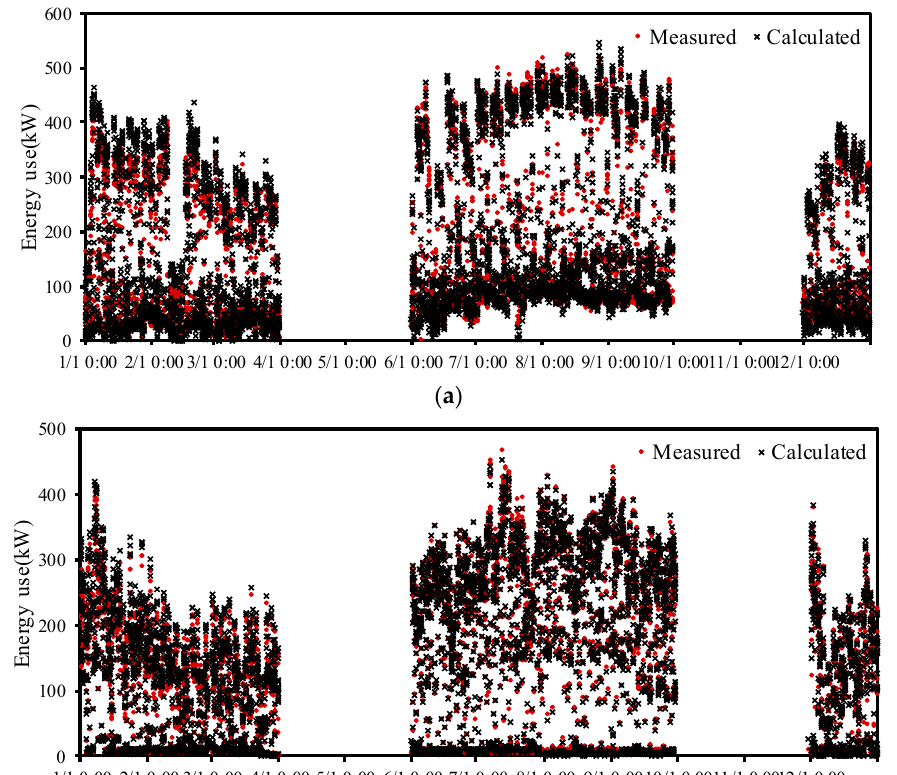
Figure 6. Energy consumption disaggregation results of HVAC terminal units: ( a ) Building A with the best training set, and ( b ) Building B with the best training set.